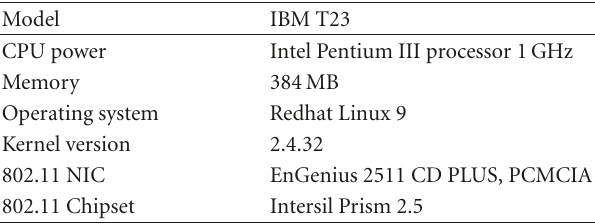
Table 3: Basic configuration of mobile